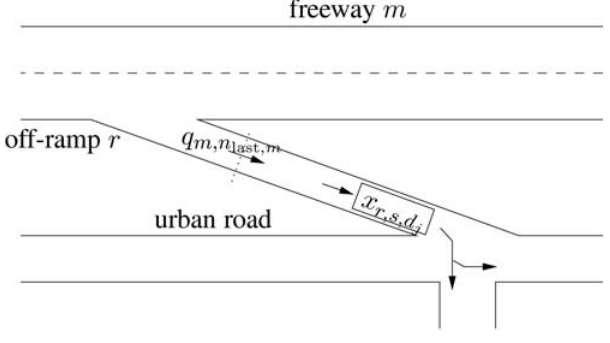
Figure 2. Layout of an